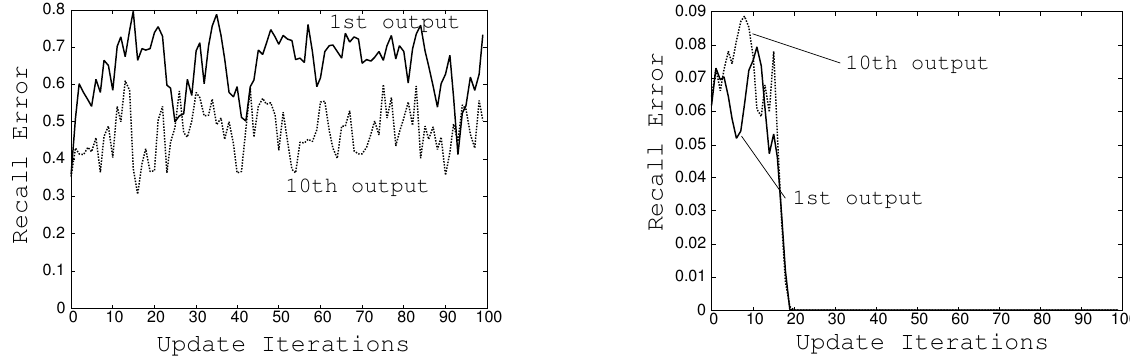
Figure 10: Recall errors of the visual images (left) and motion sequences (right) when the recalled outputs are fed back into the input of the multimodal LSTM autoencoder repeatedly, and the obtainend result is shown in Fig. 9.